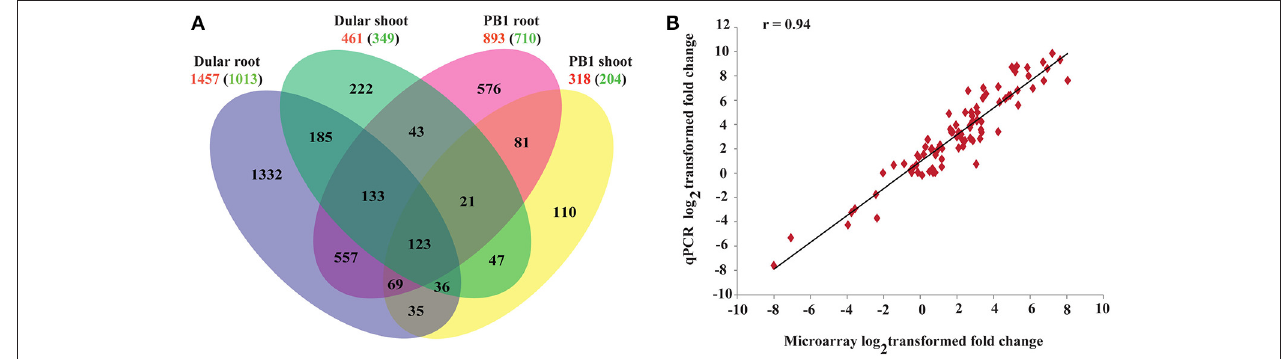
FIGURE 2 | Gene expression profiles of 15-days-old PB1 and Dular seedlings under Pi deficiency. (A) Venn diagram showing unique and commonly regulated low Pi responsive genes (FC ≥ 2) in PB1 and Dular. Numbers outside and inside the parenthesis indicate up and down-regulated genes, respectively. (B) Confirmation of microarray results with qPCR experiments. r -value represents the correlation coefficient between log 2 transformed fold changes of microarray and qPCR